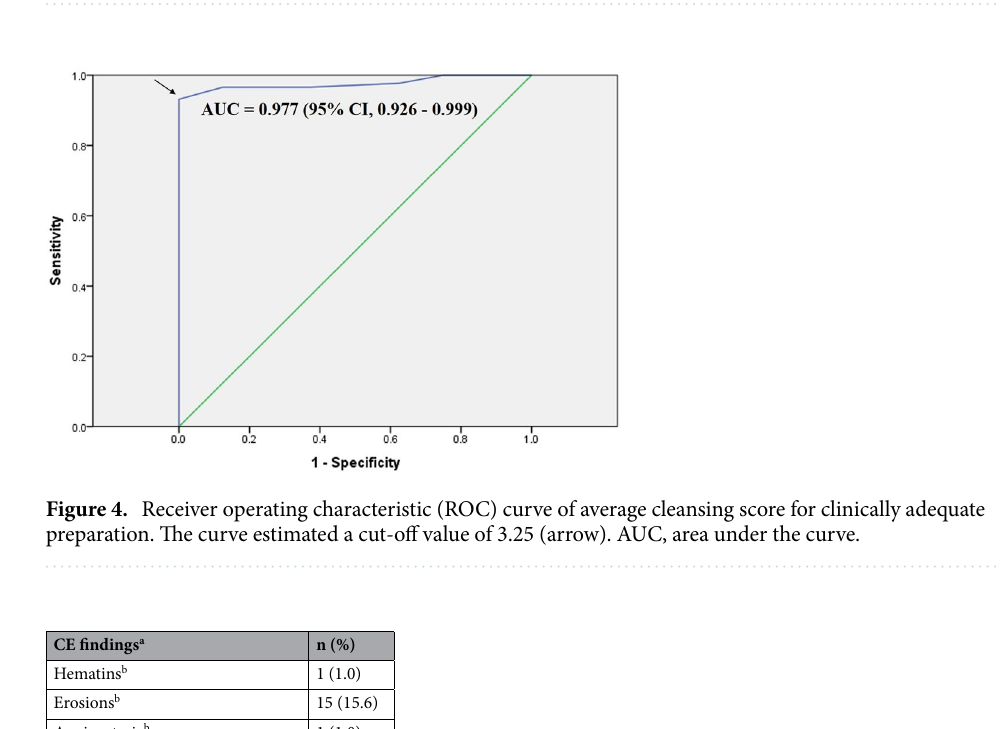
Figure 3. Average cleansing scores by ( A ) segmental grades and ( B ) overall grades. Scores decreased from grade 1 to 4 and from A to C.